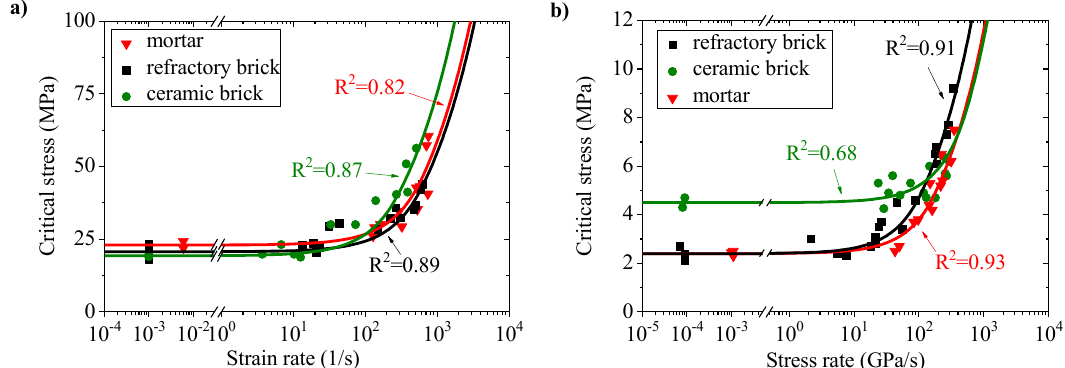
Figure 6. Critical failure stresses in quasi-brittle materials versus strain rate under compression ( a ) and stress rate under splitting ( b ). Curves are calculated by Equation (3). R 2 is the coefficients of determination.